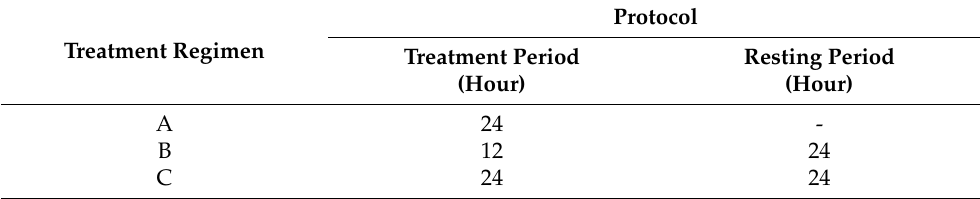
Table 1. Summary of treatment